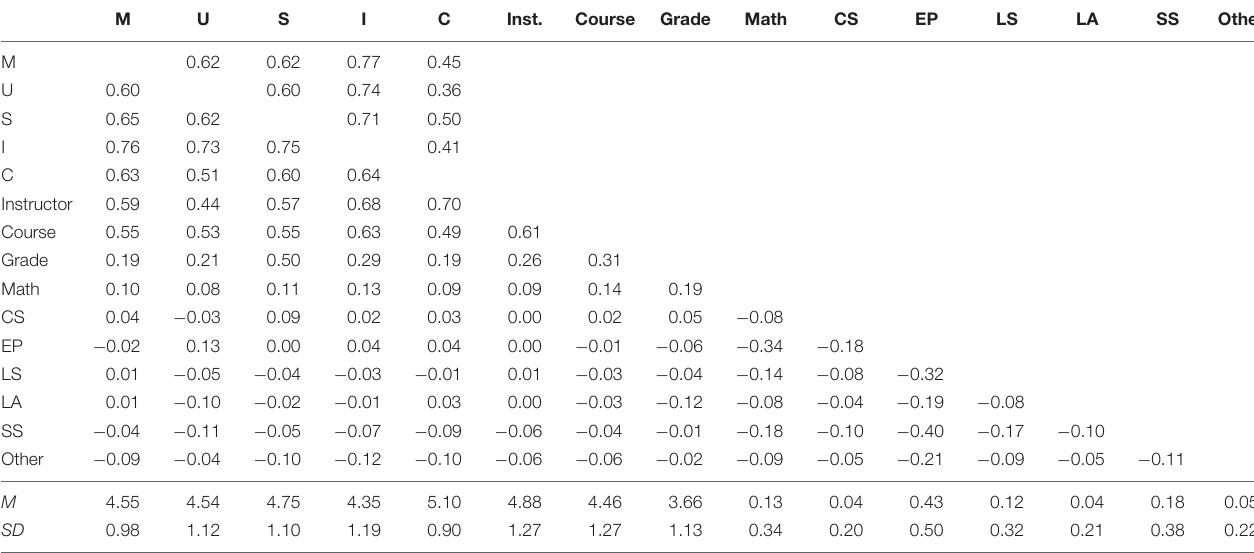
TABLE 3 | Descriptive statistics and intercorrelations for student-level variables.